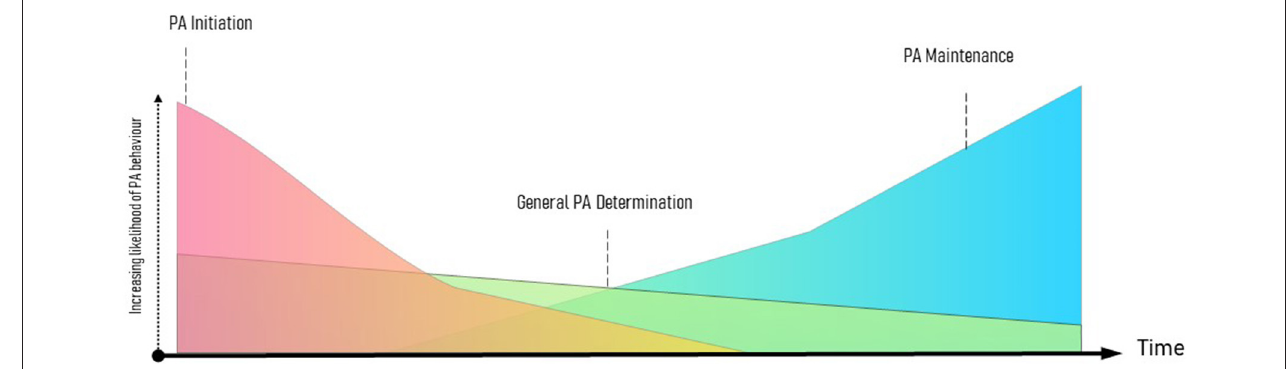
FIGURE 1 | Proposed pattern of physical activity initiation, general determination, and